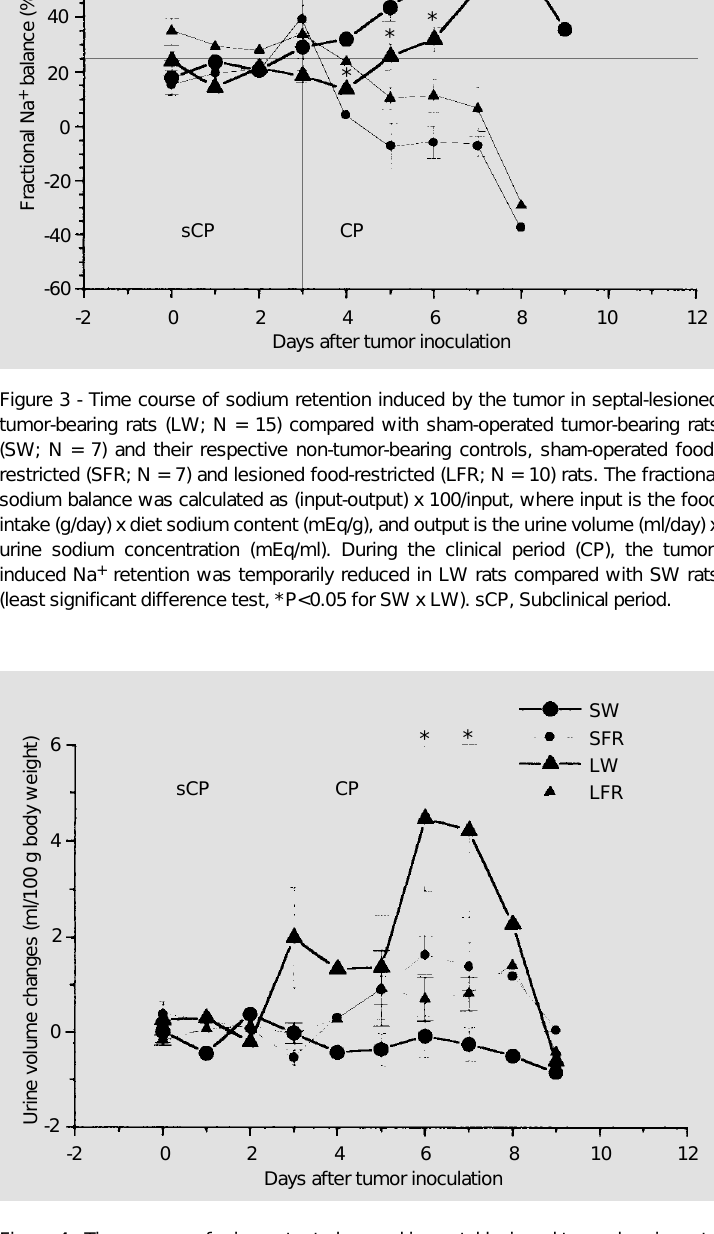
Figure 4 - Time course of urine output observed in septal-lesioned tumor-bearing rats (LW; N = 15), compared with sham-operated tumor-bearing (SW; N = 7) and their respective non-tumor-bearing controls, sham-operated food-restricted (SFR; N = 7) and lesioned food-restricted (LFR; N = 10) rats. During the clinical period (CP), the urine production was significantly increased in LW (least significant difference test, *P<0.05 for SW x LW). sCP, Subclinical